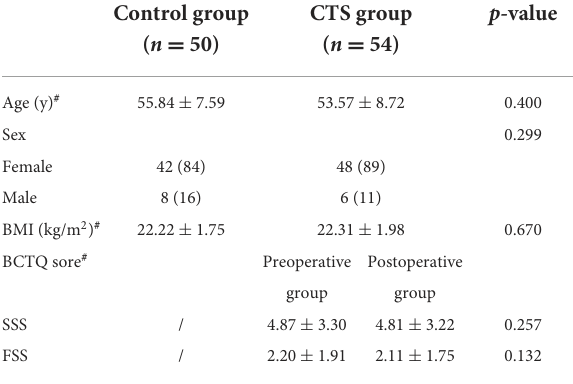
TABLE 1 Characteristics of patients.